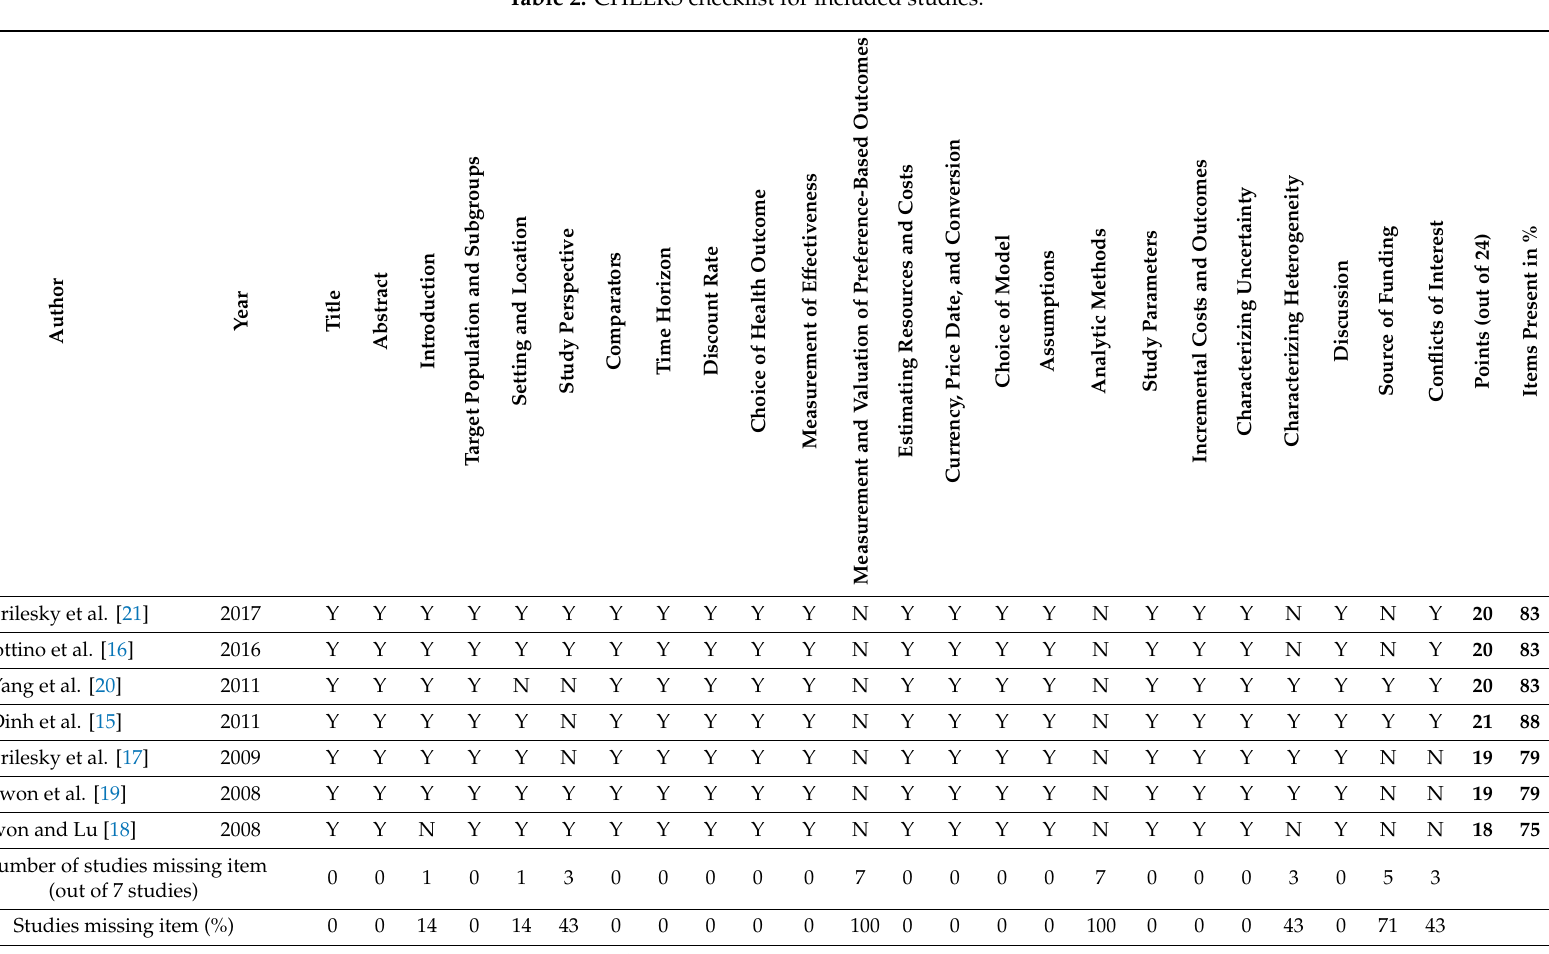
Table 2. CHEERS checklist for included